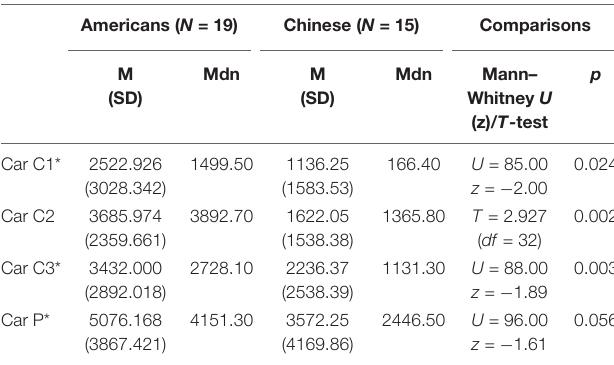
TABLE 2 | Statistics of dwell